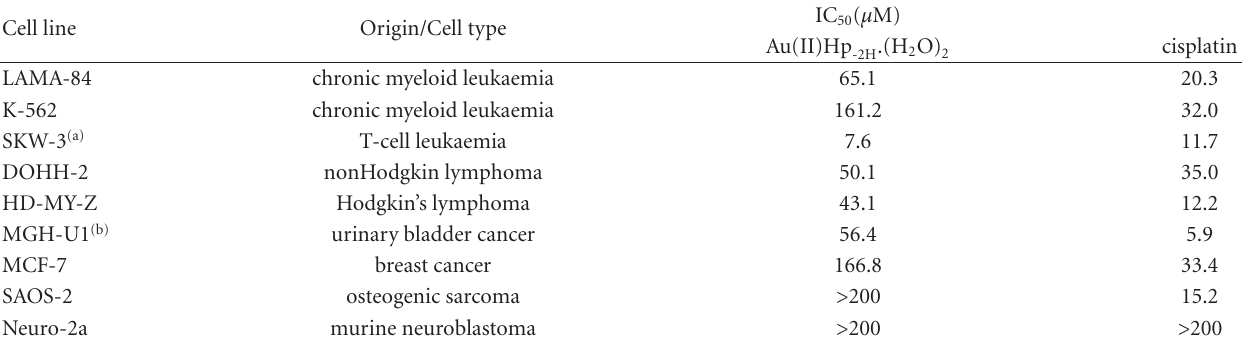
Table 1: IC 50 values of Au(II)Hp reduction assay).